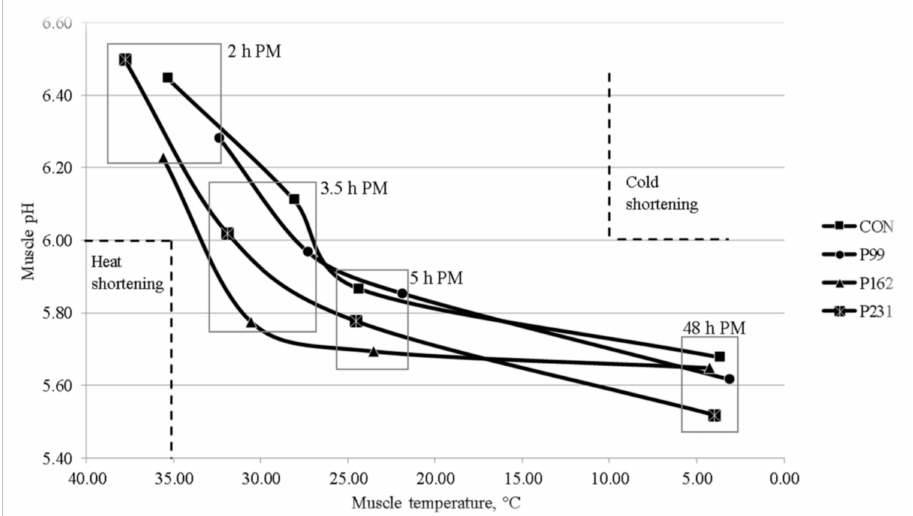
Figure 2. Post-mortem muscle pH relative to muscle temperature for bulls raised on either a concentrate system (C) or pasture-based systems (P) incorporating 99 days (P1), 162 days (P2) or 231 days (P3) of grazing prior to indoor finishing on a concentrate-based diet ( n = 14 / treatment). The zones of heat shortening (temperature ≥ 35 ◦ C at pH = 6) and cold shortening (temperature ≤ 15 ◦ C at pH = 6) are indicated by the dashed lines. Measurements were made at 2, 3.5, 5 and 48 h post-mortem